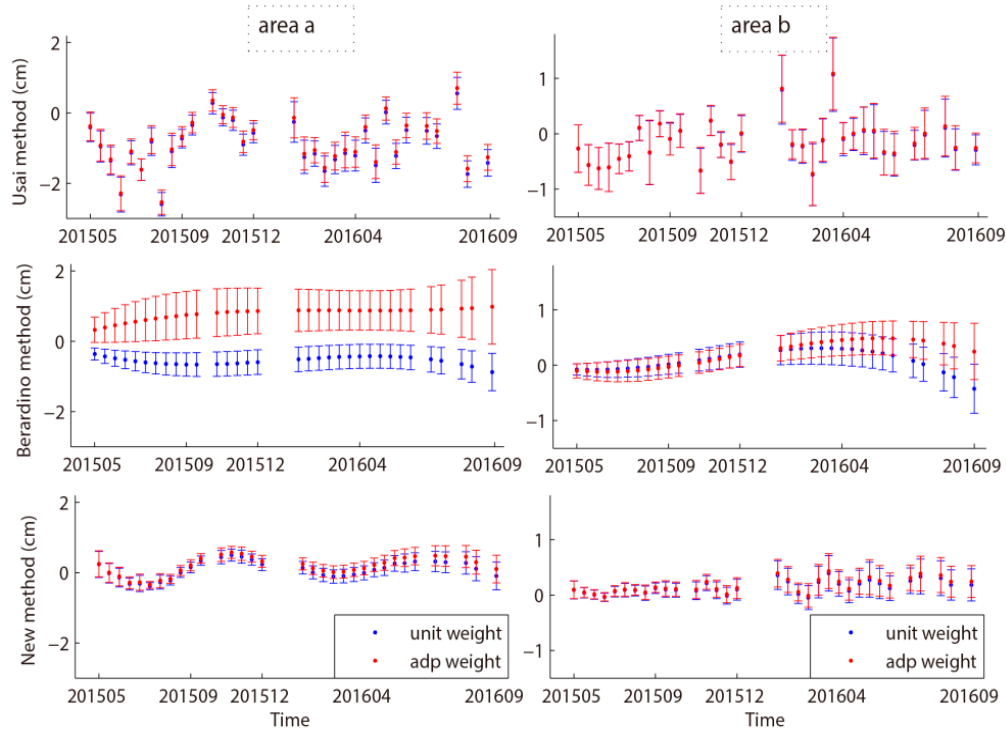
Figure 5. Time-series statistical chart in the stable areas by different functional models and weighting functions. Unit weight and adp weight represent equal and adaptive weight distributions, respectively. The left column shows the results of area a and the right column shows the results of area b. The figures in the three lines show the time-series results of the Usai method, the Berardino method and the proposed method, respectively.